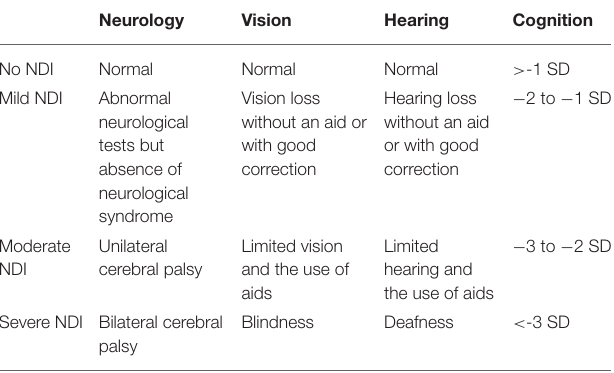
TABLE 1 | Classification of neurodevelopmental